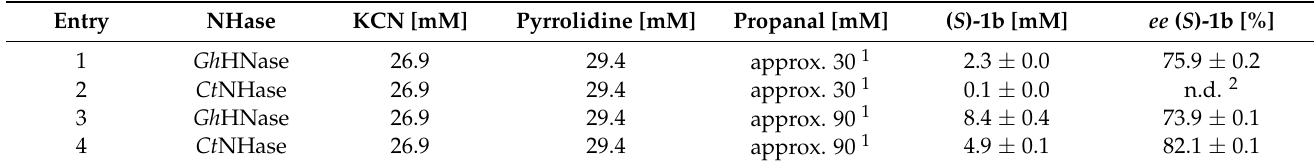
Table 2. One-pot enzymatic dynamic kinetic resolution by Strecker reaction from three precursors. Conditions: pH 7.3, 25 ◦ C, 344 µ g/mL of Gh NHase, 30 min reaction time.